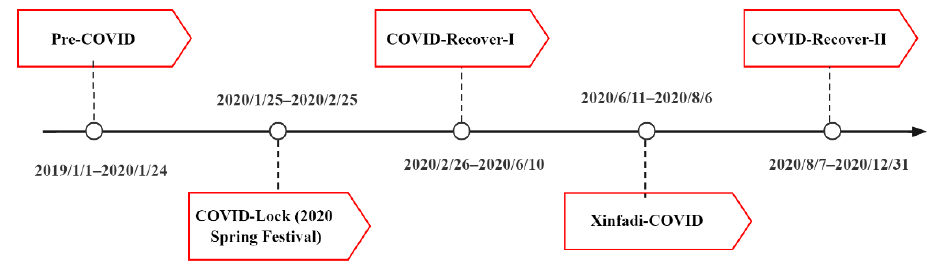
Figure 1. Timeline of five periods of the COVID-19 pandemic of Beijing, China